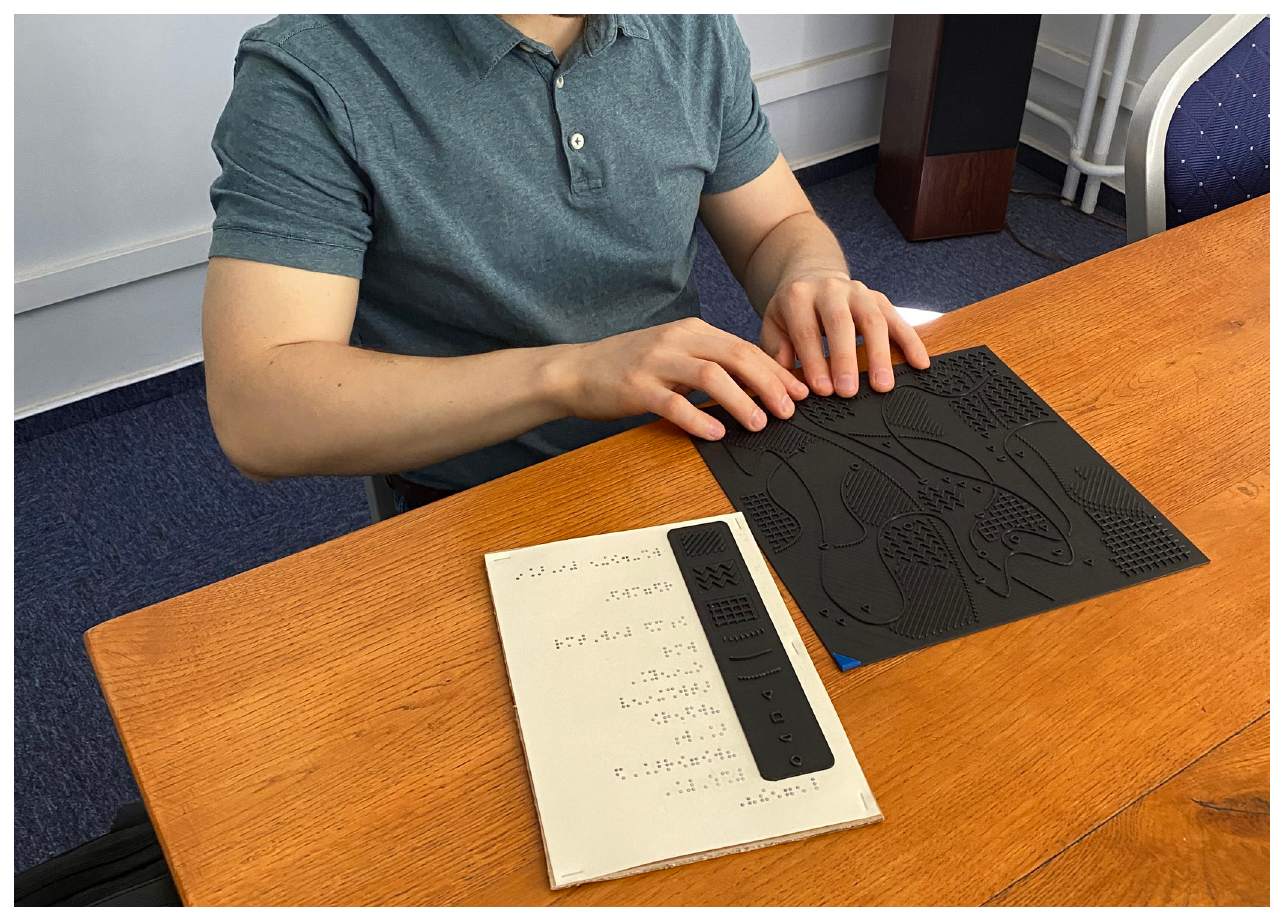
Fig 7. One of the study participants during the testing phase, source: Own